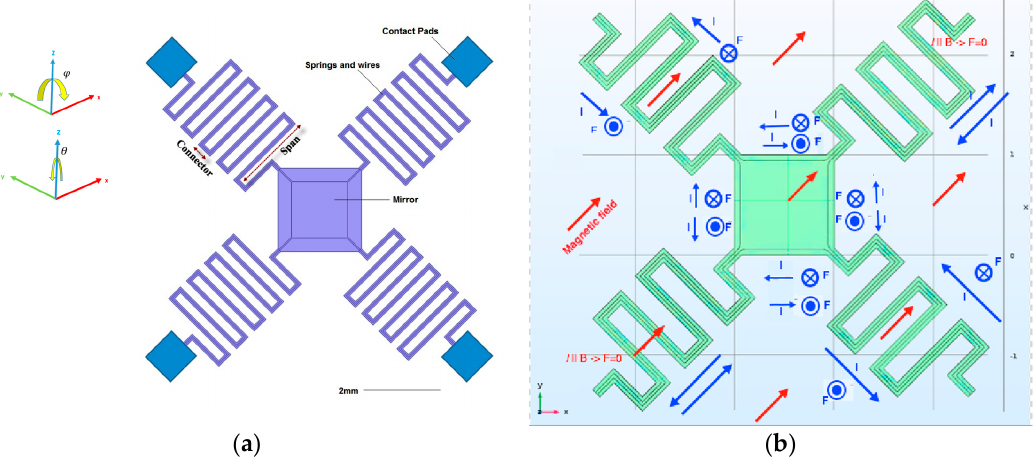
Figure 1. ( a ) Schematic of the actuator; ϕ and θ show the direction of rotation; ( b ) Red arrows show the magnetic field; blue arrows show direction of current; and circular signs show direction of